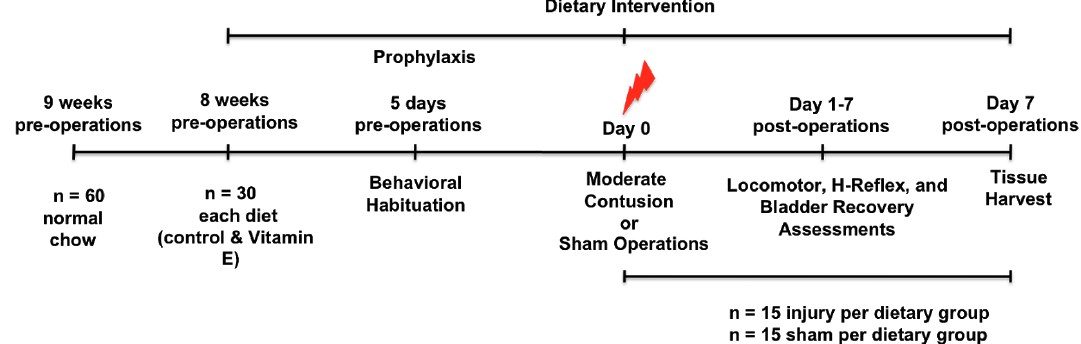
Figure 1. Timeline showing the vitamin E diet supplementation schedule and the time points of behavioral assays, surgical procedures, and tissue sample collection.